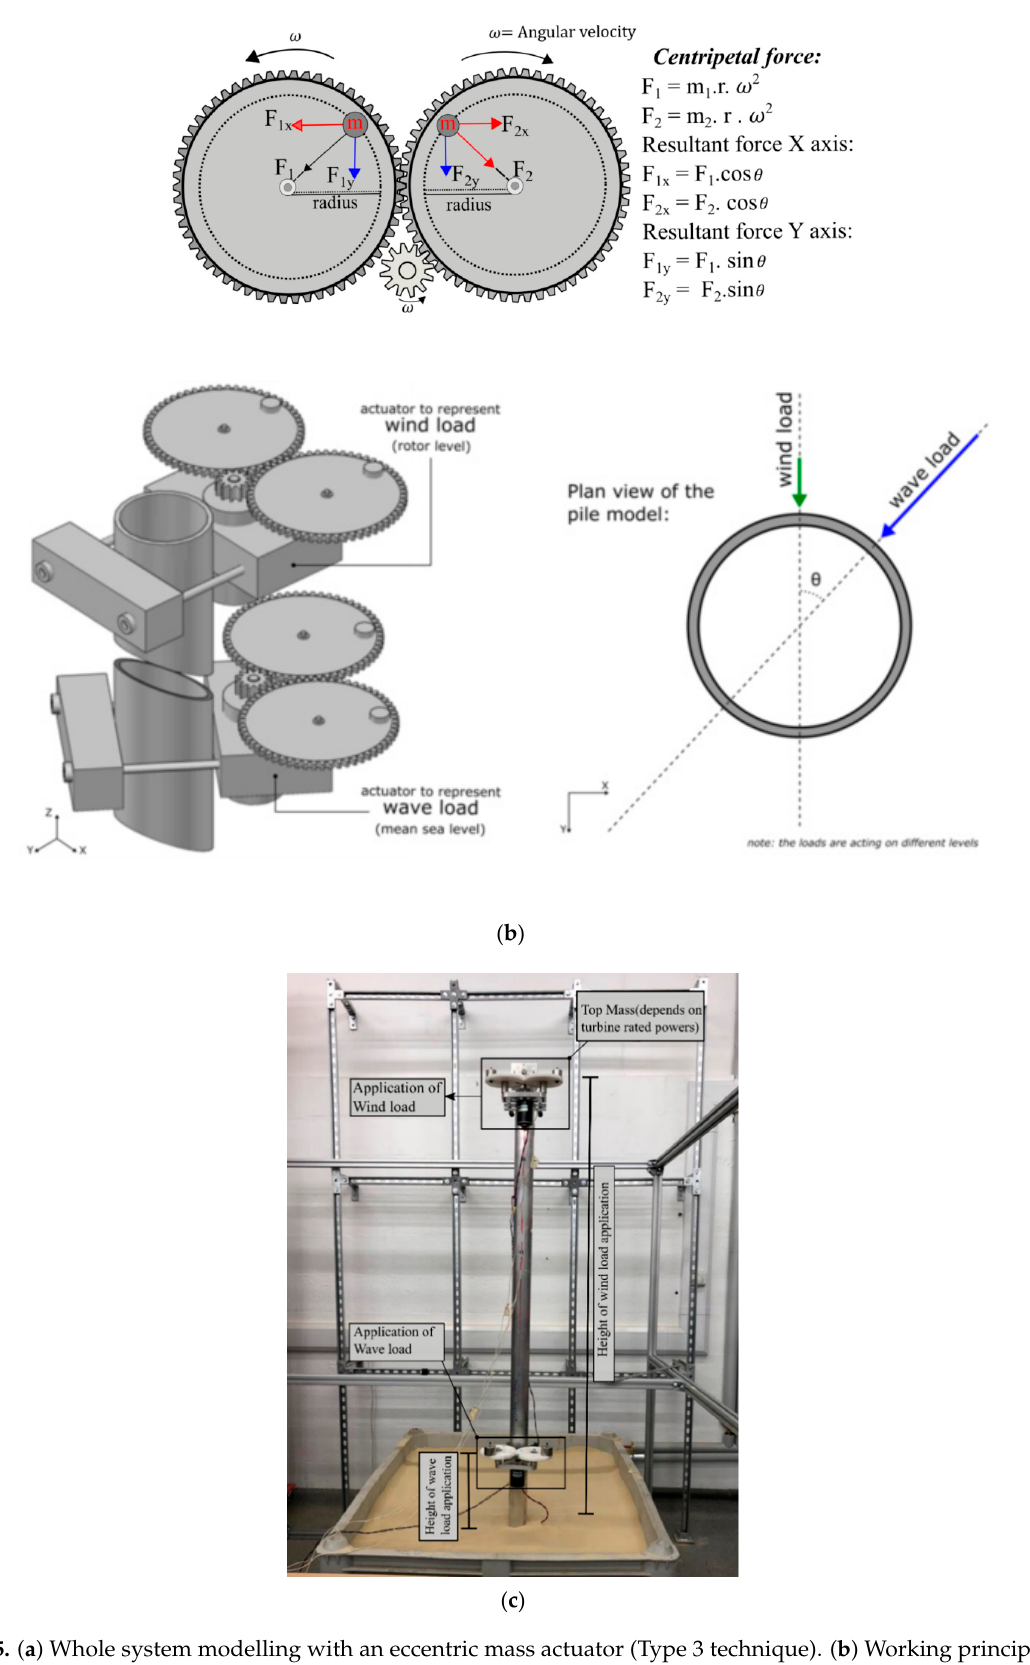
Figure 16. Examples of the Type 3 technique used in Zhejiang University (China).